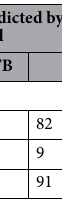
Table 4. Confusion matrix report for existing weighted voting ensemble method.